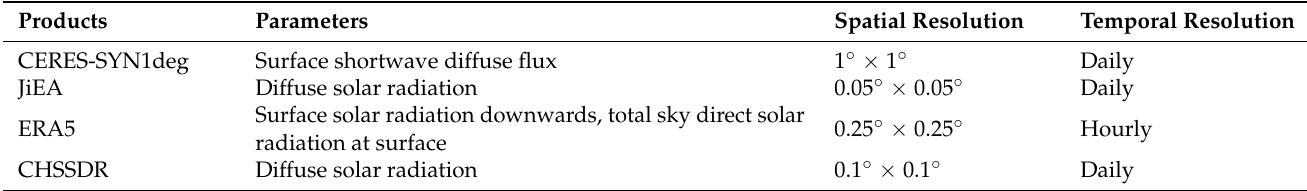
Table 2. Details of surface diffuse solar radiation products used in this study. CHSSDR is the surface diffuse solar radiation dataset constructed in this